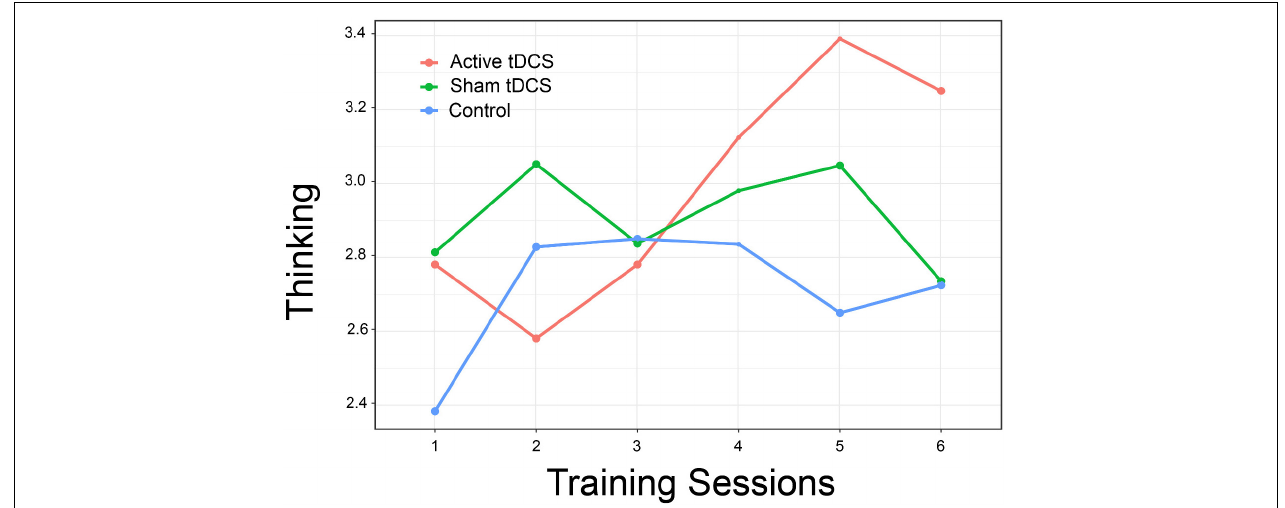
FIGURE 7 | Participants’ self-rated thinking and memory by Group and Training Session.